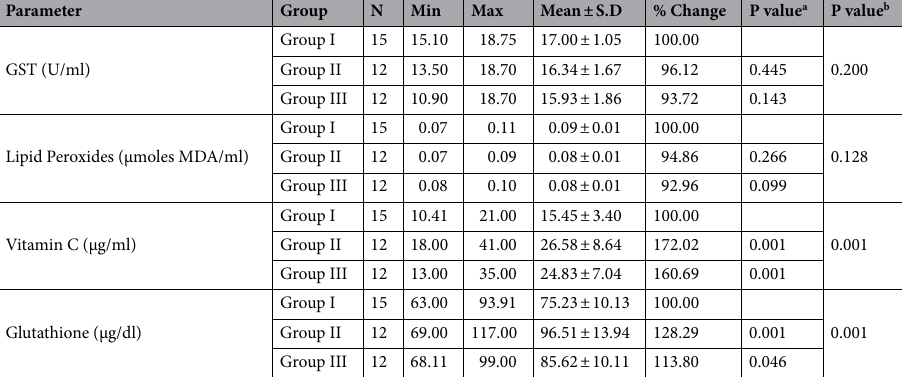
Table 5. Mean ± SD and percentage changes of the four measured parameters in the serum of controlled diabetic patients with and without retinopathy compared to healthy control subjects. Comparisons done using one-way ANOVA test between all groups with multiple comparisons (Dunnett test) to compare each group with the control group in all parameters. a P value between each group and the control group. b P value between all